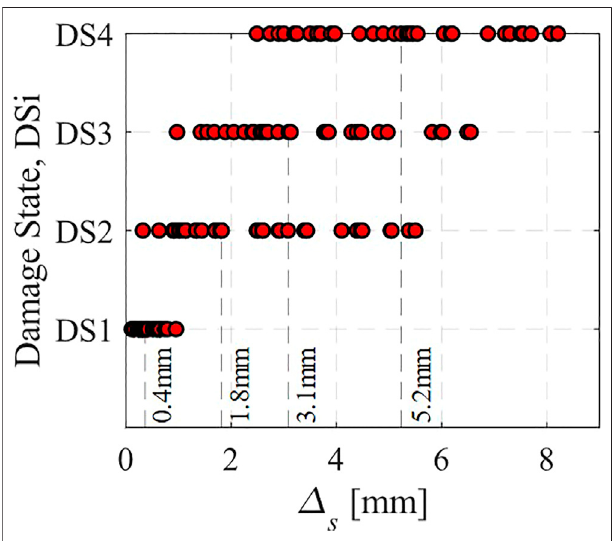
FIGURE 3 | Distribution of slip demands, Δ s , corresponding to the four damage